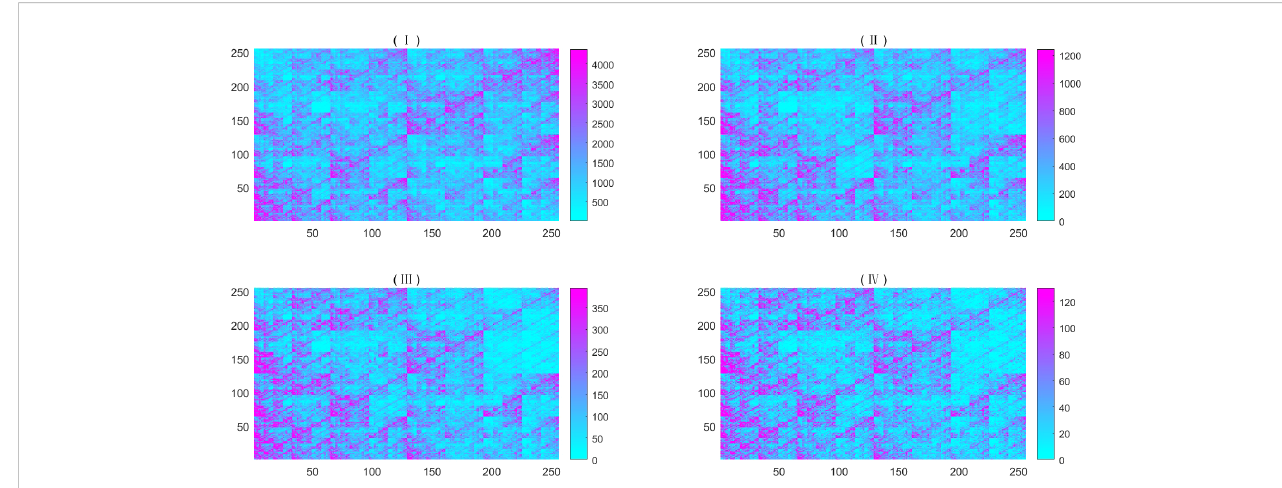
FIGURE 1 Heat map of simulated metagenome of dataset 2, the abundance are 0.016928832, 0.30559462, 0.120814049, 0, 0.07959993, 0.00894306, 0.03682631, 0.37768779, 0.00570905, and 0.04789635. The dissolution of (I) is 256×256; (II) is an image magni fi ed by a factor of 2 from the upper left part of (I); (III) is an image magni fi ed by a factor of 2 from the upper left part of (II); and (IV) is an image magni fi ed by a factor of 2 from the upper left part of (III). For better visibility, we regarded the number exceeding the threshold as the threshold, whose values are taken three times the mean value.